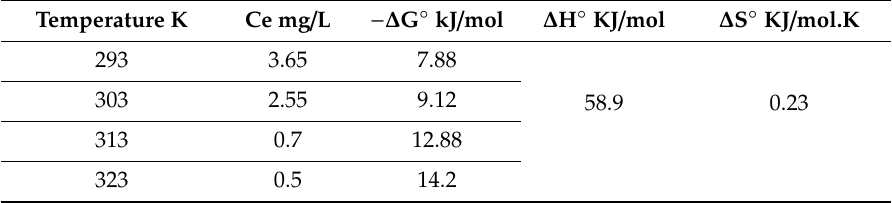
Table 9. Thermodynamic parameters for CIP adsorption by ZIF-67-SO